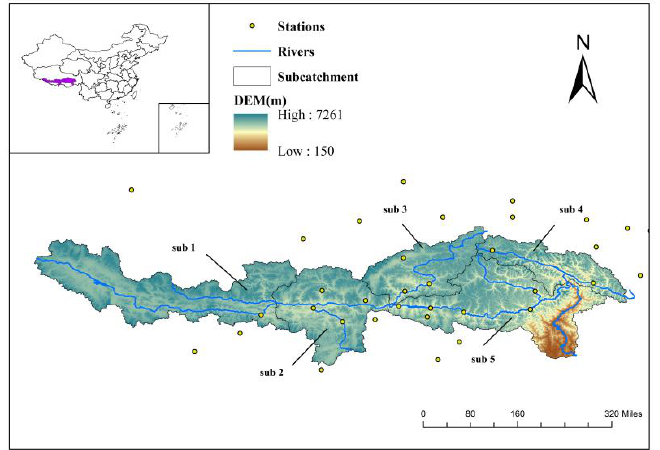
Figure 1. Location of the Yarlung Zangbo River Basin (YZRB) and its five subzones.